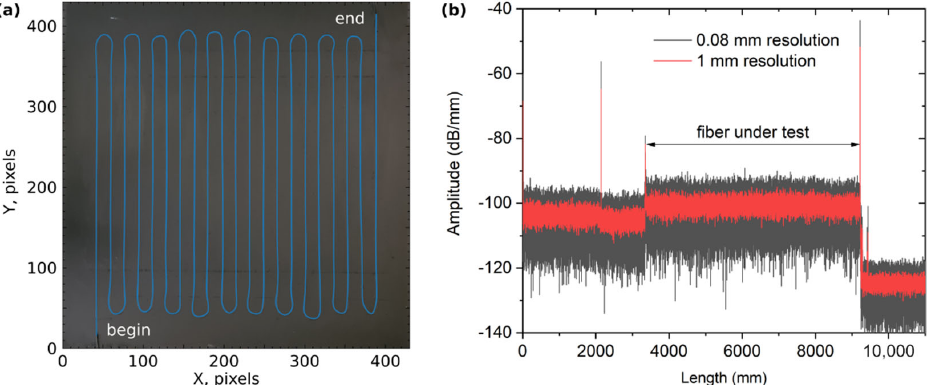
Figure 2. ( a ) Photo of the sensor panel with the integrated FUT (highlighted in blue). The scales correspond to the pixels on the IR thermal imager (1.7 pixels per 1 mm). ( b ) Reflectogram of the FUT measured with a LUNA OBR 4600 after assembly of the panel.